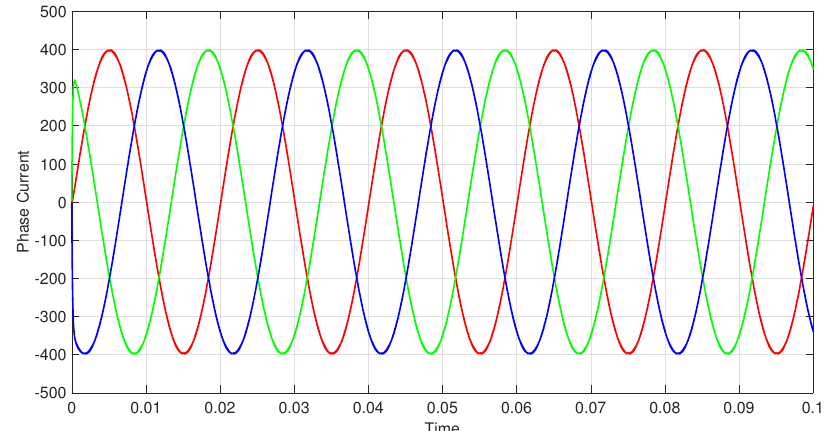
Figure 12. Three-phase output current waveforms.